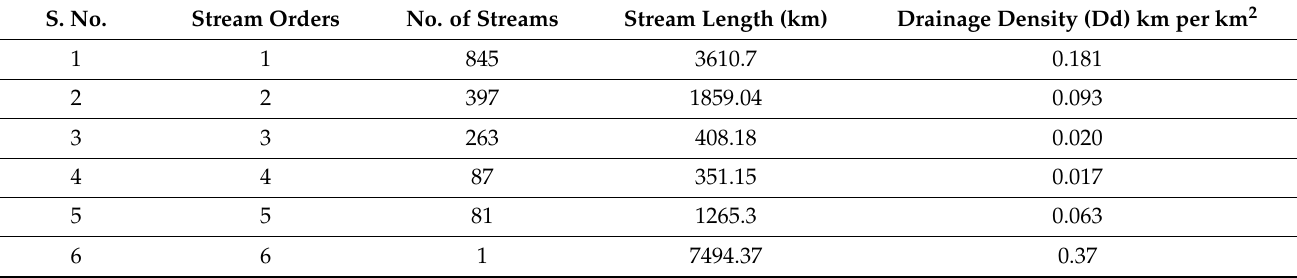
Table 3. Drainage density and stream number.